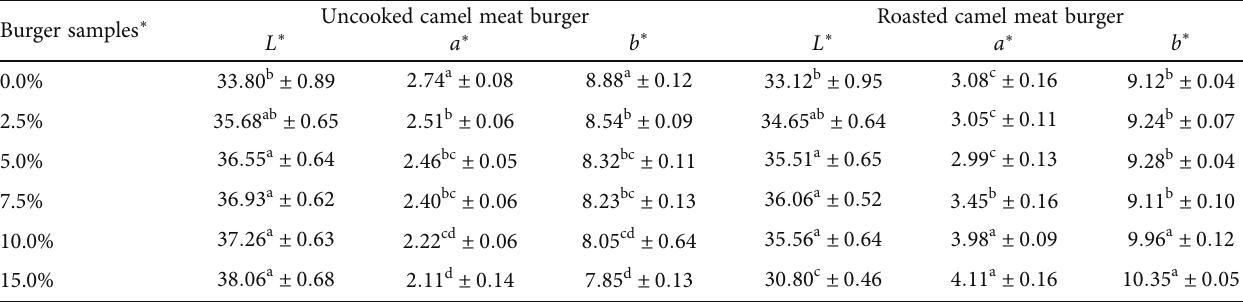
Table 6: Instrumental color characteristics of uncooked and roasted camel meat burger as a ff ected by adding various levels (%) of UBDF as a fi ber source. Uncooked camel meat burger Roasted camel meat burger Burger samples ∗ L ∗